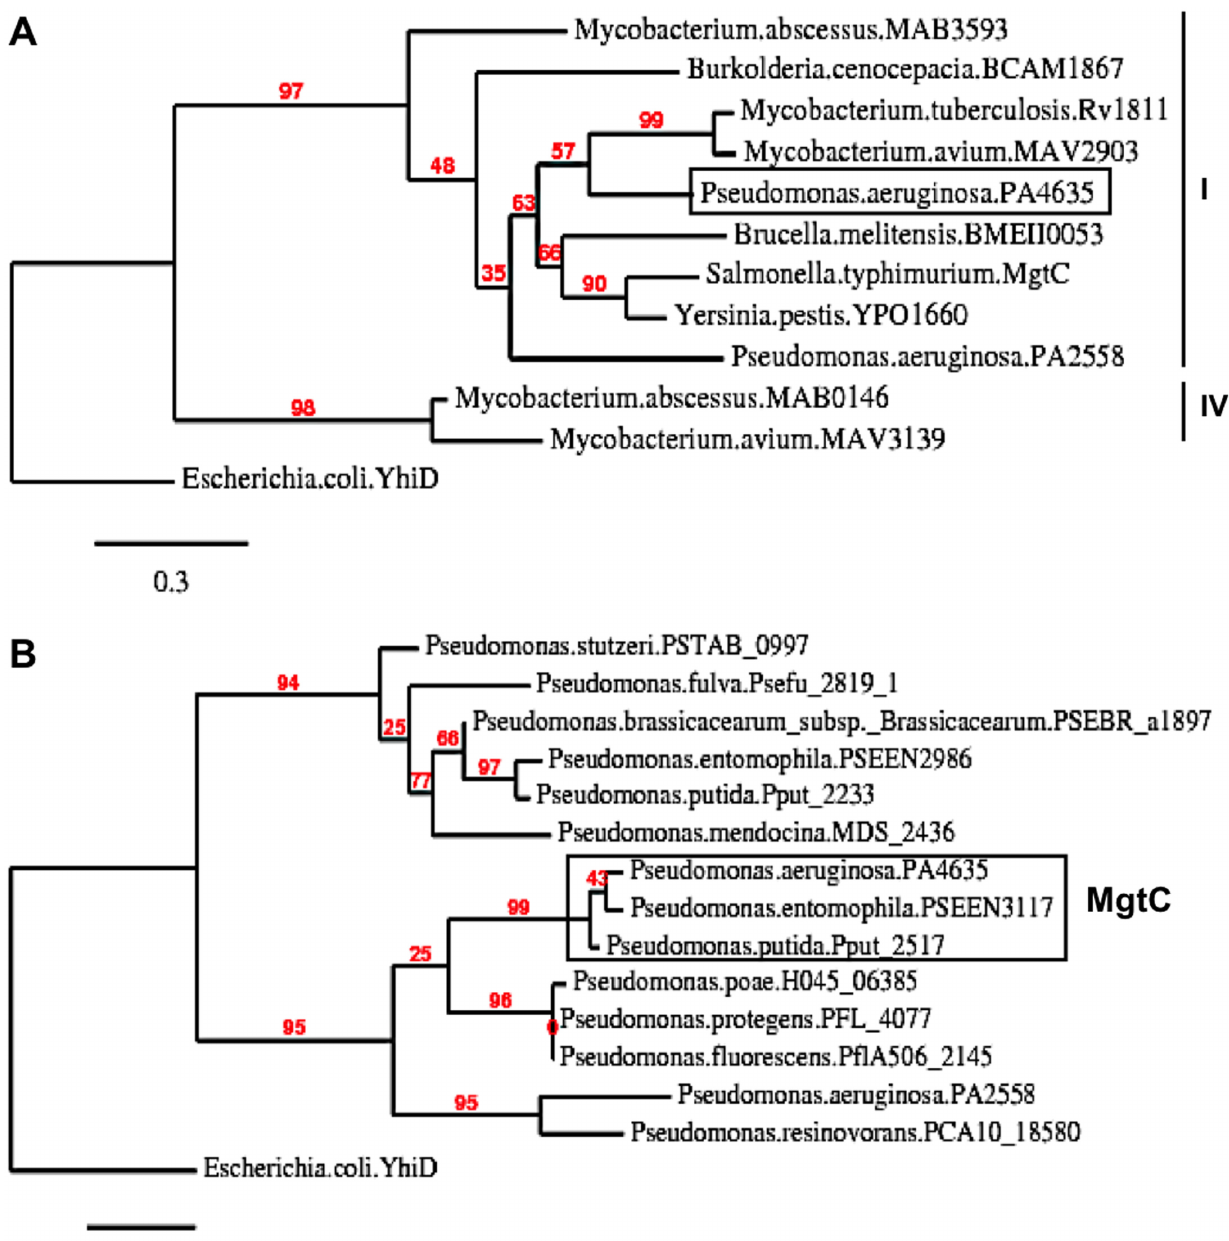
Fig 1. Phylogenetic analysis of Pseudomonas MgtC-like proteins. (A) Phylogenetic tree of MgtC-like proteins from bacterial pathogens that survive in macrophages for which MgtC role in virulence has been studied ( S . Typhimurium, M . tuberculosis , B . suis , B . cenocepacia , Y . pestis ) and opportunist bacterial pathogens found in CF patients ( P . aeruginosa , B . cenocepacia , M . avium , M . abscessus ). Several bacteria, including P . aeruginosa , encode two MgtC-like proteins. Phylogenetic analyses were carried out with the “ Phylogeny.fr ” web server (http://www.phylogeny.fr) [57] using MUSCLE, PhyML and TreeDyn softwares. Numeration of phylogenetic groups follows a previous analysis [58]. Escherichia coli YhiD is used as a distantly related MgtC-like protein [16] to root the tree. (B) Phylogenetic tree of MgtC-like sequences recovered from Pseudomonas genomes. MgtC-like protein sequences were recovered from BlastP analysis using PA4635 sequence on completed genomes from the Pseudomonas genome database (http://v2.pseudomonas.com/) [23]. PA4635 is conserved ( > 99% identity) in the 10 P . aeruginosa genomes other than PAO1 found in the Pseudomonas database, including the divergent strain PA7. Besides P . aeruginosa genomes, MgtC is found in P . entomophila and P . putida ( > 85% identity with PA4635). Other genomes harbors MgtC-like proteins that differ from PA4635 ( < 40% identity with PA4635).